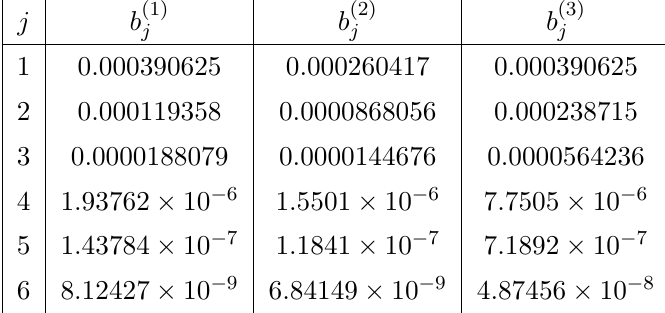
Table 2 . The coefficients b ( i )